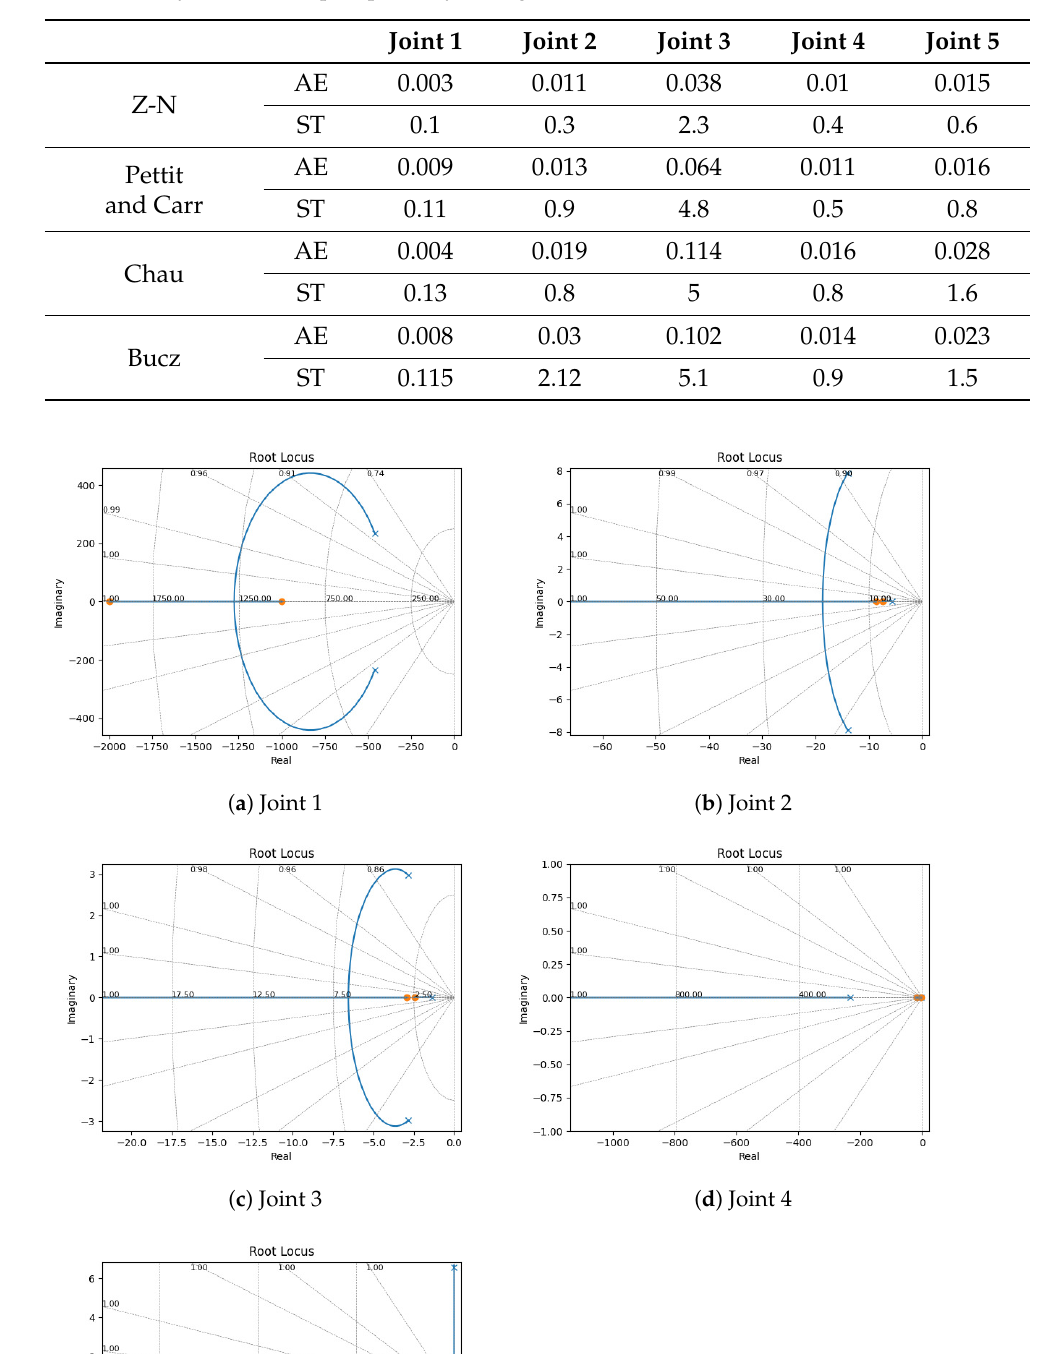
Table 4. Analysis of unit step response by tuning methods for each link.